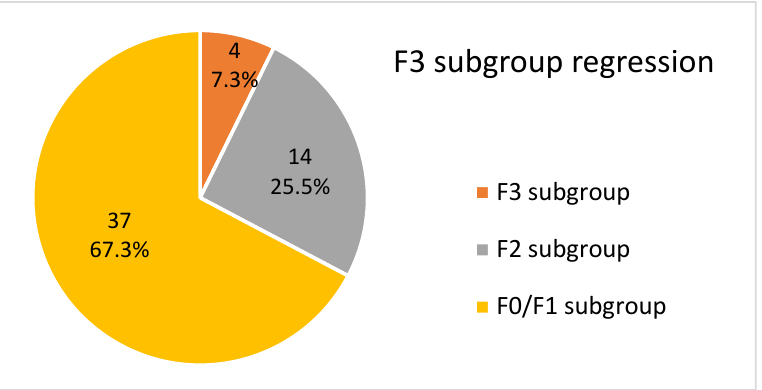
Figure 11. Graphic description of the fibrotic stage in F3 patients at the end of the follow-up